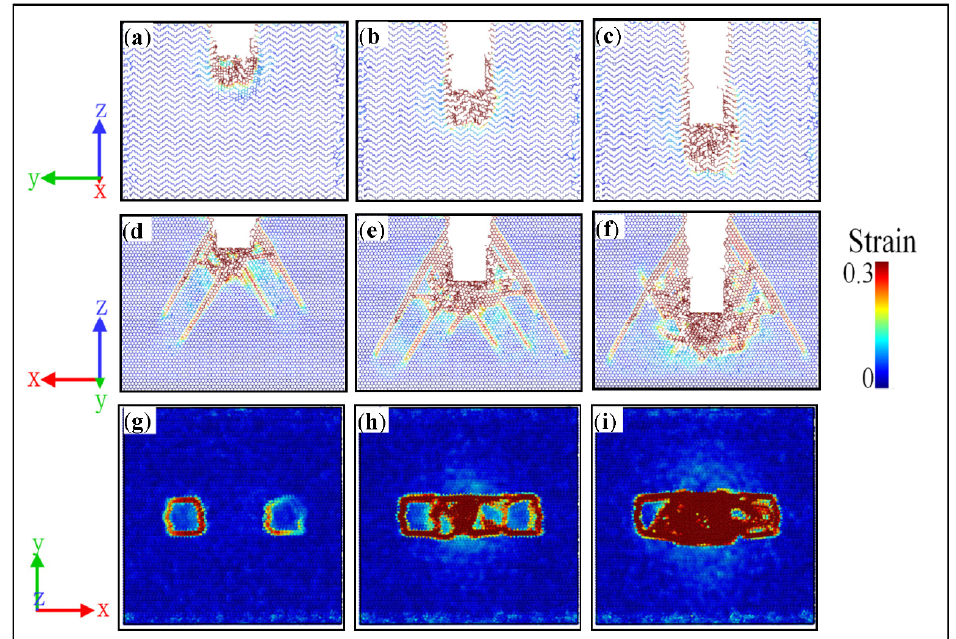
Figure 6. Shear strain nephogram of 6H-SiC (11 — 00) crystal plane with different indentation depths. ( a ), ( d ) and ( g ) are the shear strain nephograms in different directions when the indentation depth is 3 nm, ( b ), ( e ) and ( h ) are the 6nm indentation depth, ( c ), ( f ) and ( i ) are the 9 nm indentation depth